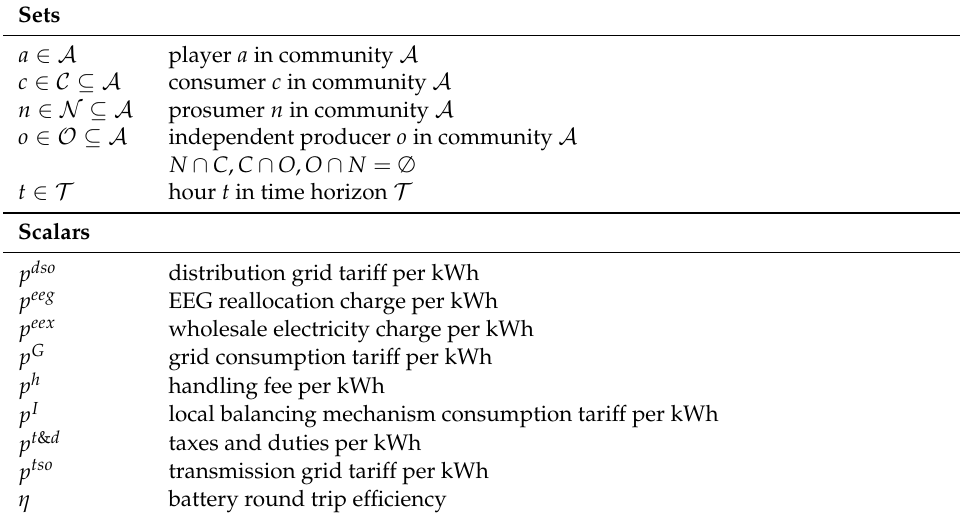
Table 1. Designated sets, parameters and variables of the mathematical